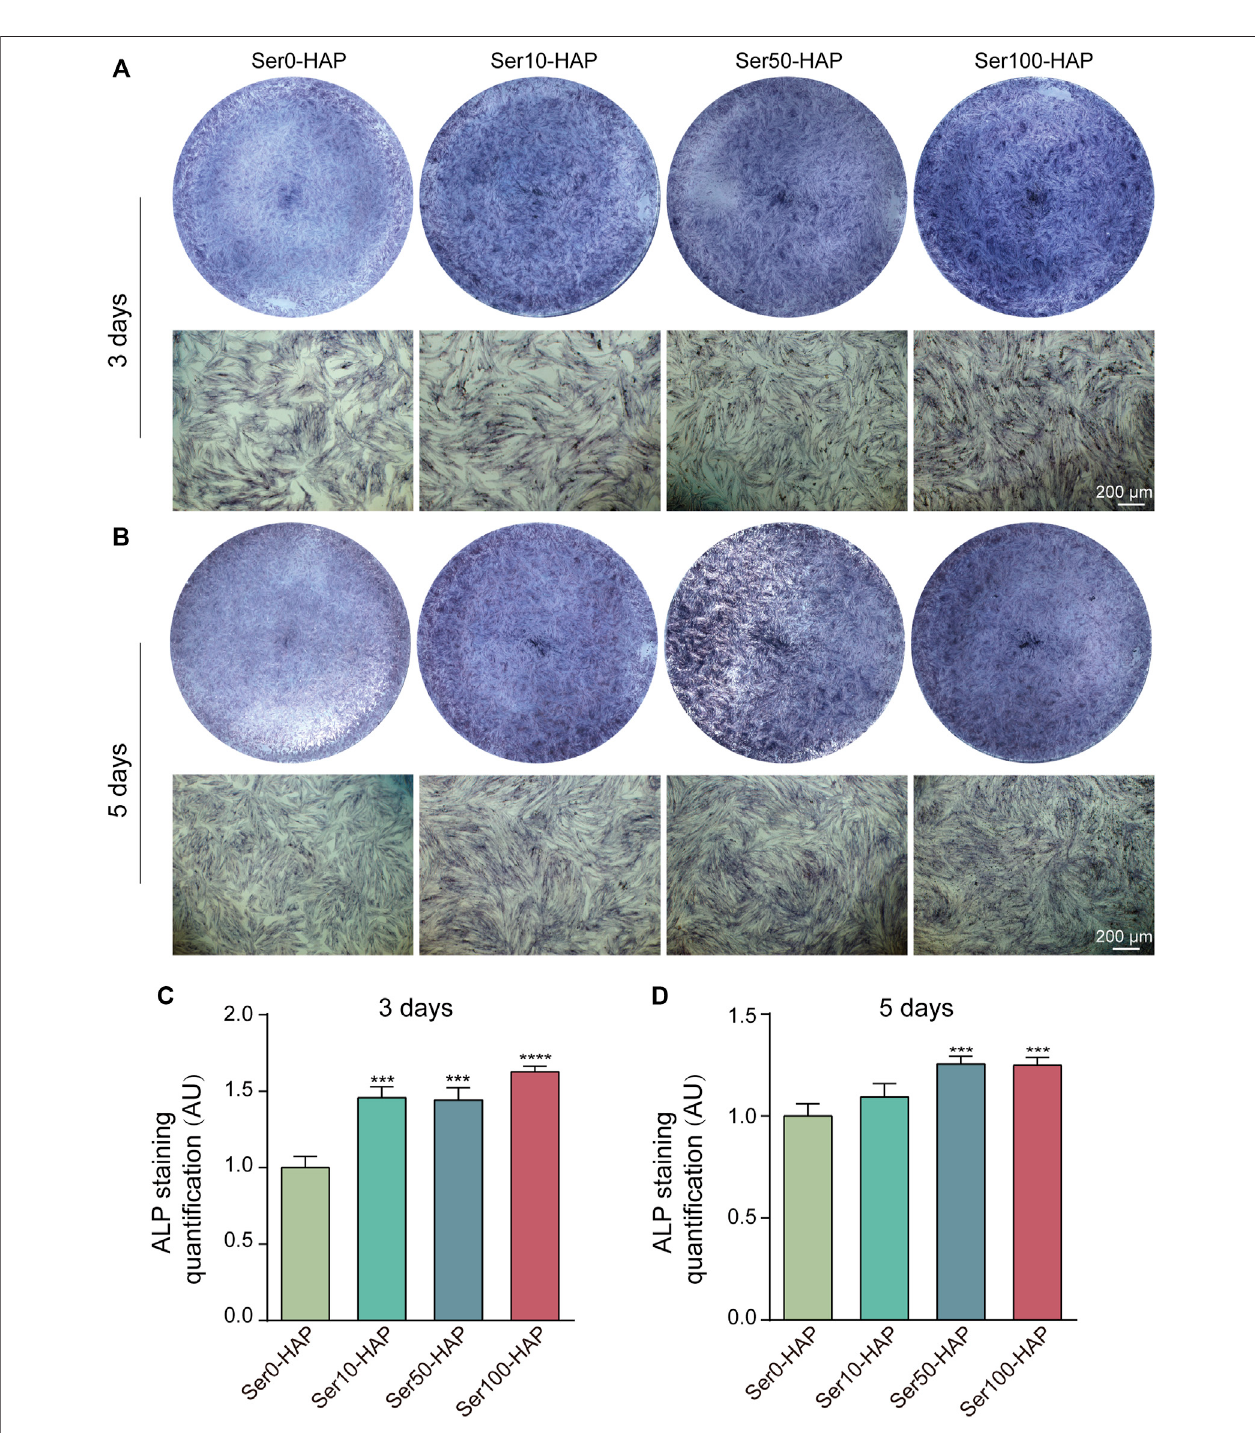
FIGURE 4 | ALP staining of hPDLSCs after culture with Ser-HAP for 3 days (A) and 5 days (B) ; Quantitative analysis of ALP staining at 3 (C) and 5 days (D) .